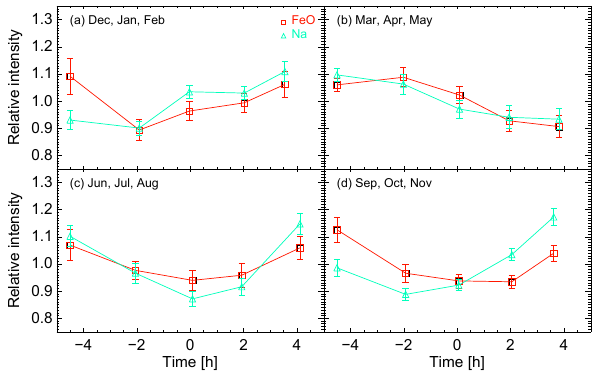
A 0 denotes the annual mean intensity in rayleighs. A 1 is the amplitude of the annual oscillation in rayleighs. In parentheses the relative value of A 1 to A 0 is given as a percentage. A 2 is the amplitude of the semi-annual oscillation in rayleighs. The values in parentheses are the same as for A 1 . ϕ 1 is the phase shift of the annual oscillation in DOY. ϕ 2 is the phase shift of the semi-annual oscillation in DOY. The column “Method” refers to the fit used for the model. Best fit was achieved with a least squares fit. Mean is the value retrieved with a Bayesian approach, with σ as the standard deviation. The comparison data are from Cachoeira Paulista (Takahashi et al., 1995).